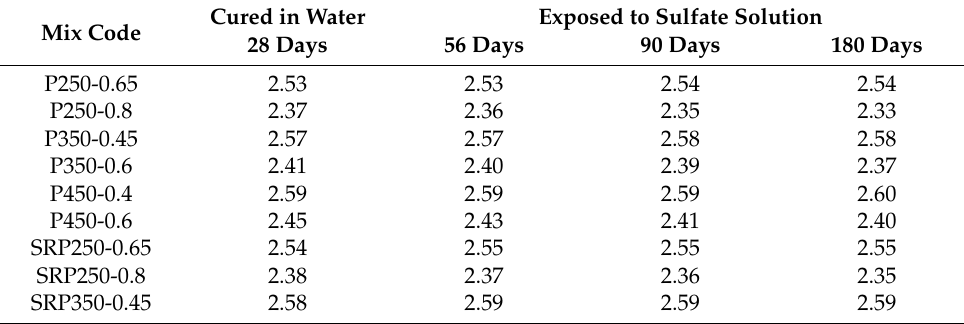
Table 6. Sulfate attack influence on specimens’ weight